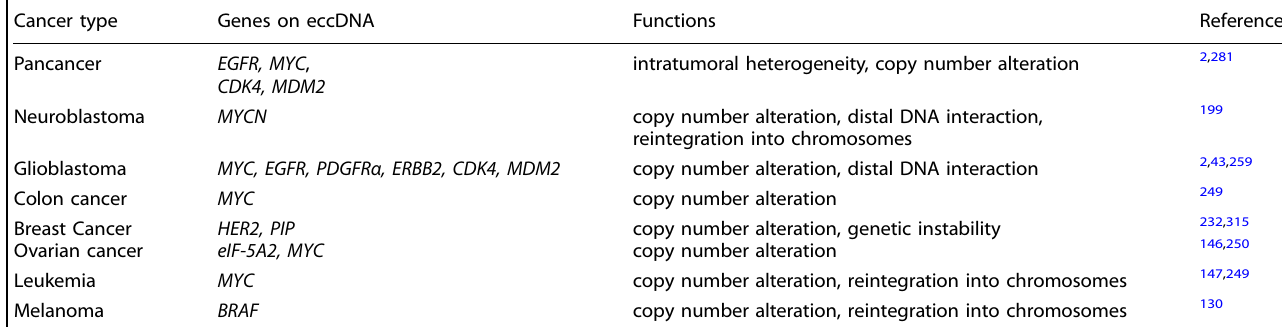
Table 2. Summary of the roles of eccDNA in development Cancer type